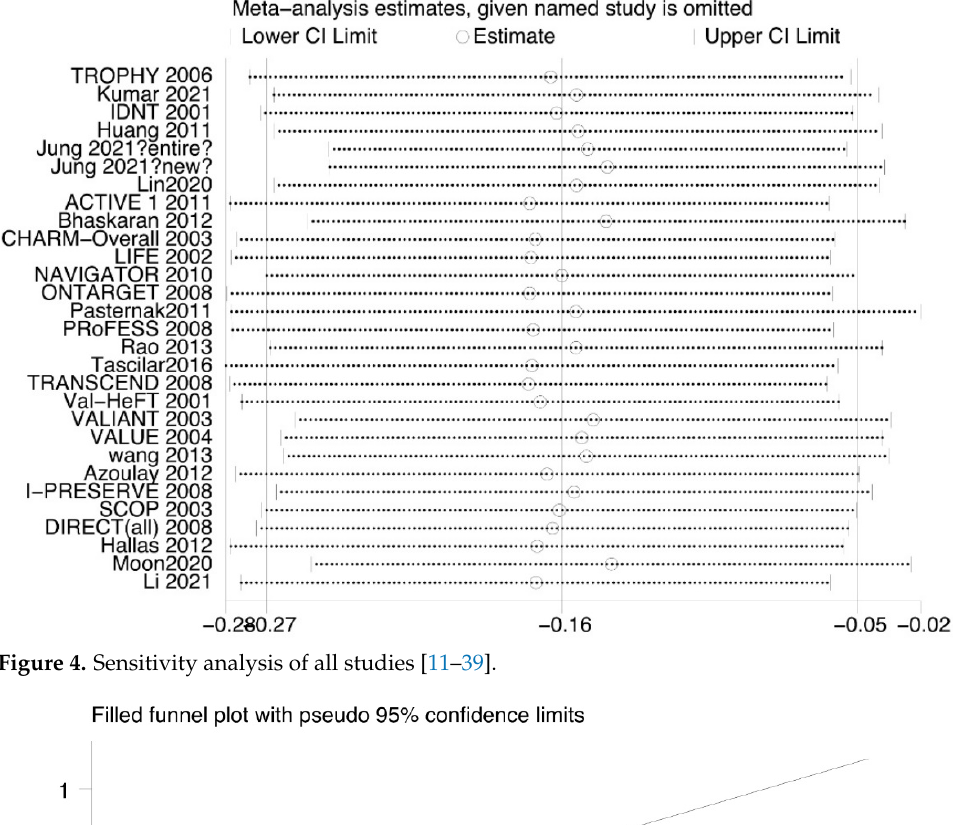
Figure 4. Sensitivity analysis of all studies [11–39].